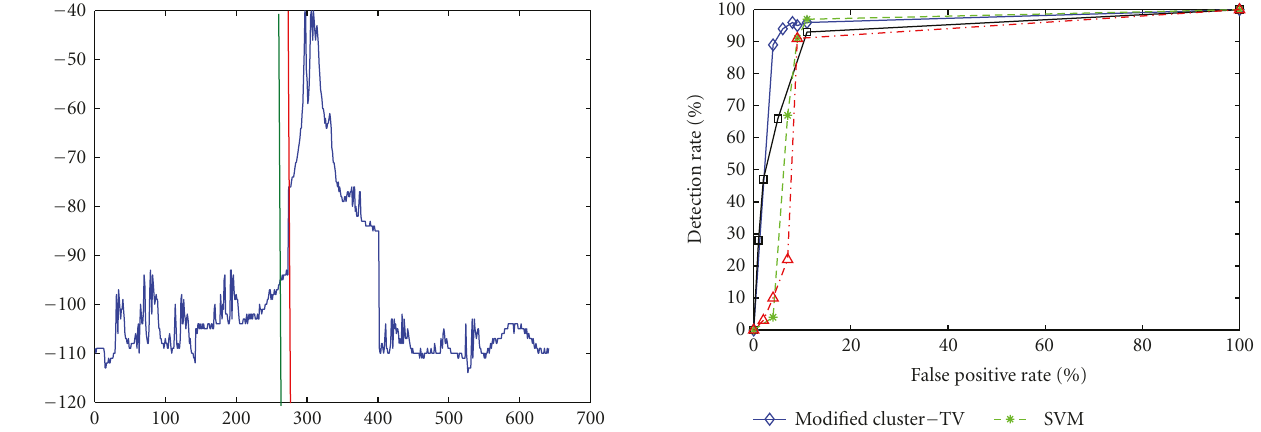
Figure 4: Transient detection from a signal generated by a WLAN transceiver and shifted by 10 samples. Figure 5: Performance of the geometric clustering algorithm with respect to existing approaches.